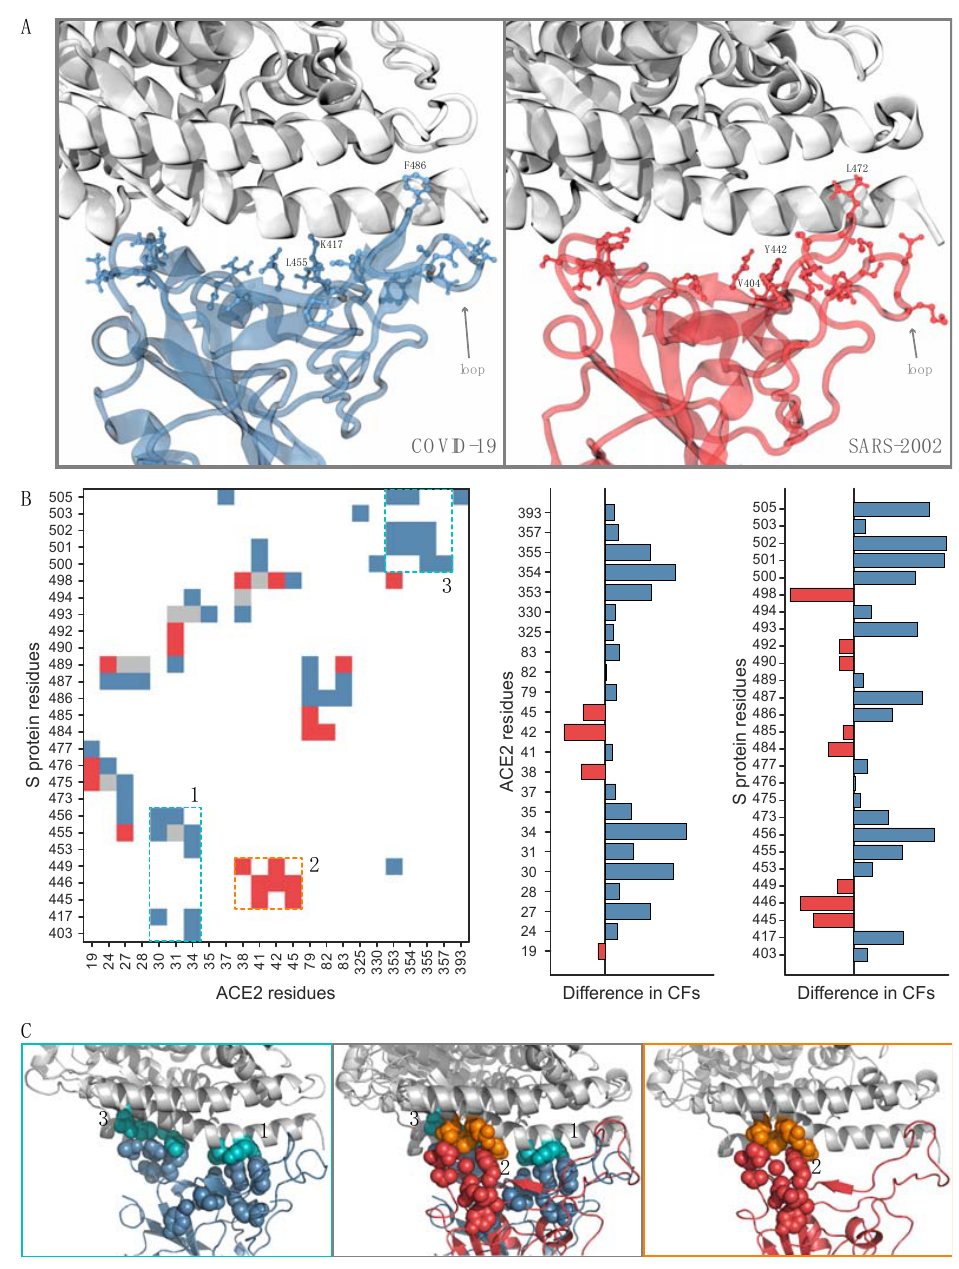
Figure 2. Interaction interfaces of RBD–ACE2. A residue is considered as part of the interface if one of its atoms is within 4 Å from any atom of the other partner in at least 30% of the 10,000 MD simulation frames. ( A ) The interface residue side-chain heavy atoms that vary between COVID-19 (blue) and SARS-2002 (red) are shown with ball-and-stick representations. ACE2 is colored gray; ( B ) the contacts di ff erence plot between COVID-19 and SARS-2002 (left). A residue–residue contact frequency (CF) is defined as the fraction of MD trajectory frames in which the contact appears. The contacts with 50% greater CF in COVID-19 RBD–ACE2 vs. SARS-2002 RBD–ACE2 are colored blue. The contacts with 50% greater CF in SARS-2002 RBD–ACE2 vs. COVID-19 RBD–ACE2 are colored red. Similar interface-residue CFs ( < 50% di ff erence) in both RBDs are colored gray. The residue numbering is according to COVID-19 (RefSeq: YP_009724390.1). Di ff erence plots for interface residue CFs that are in the interface for ACE2 (middle) and RBD (right); ( C ) zooms on the interface contacts unique to each virus. The COVID-19 patches are colored blue with the corresponding ACE2 patches in cyan, and the SARS-2002 patch is in red with the corresponding ACE2 patch in